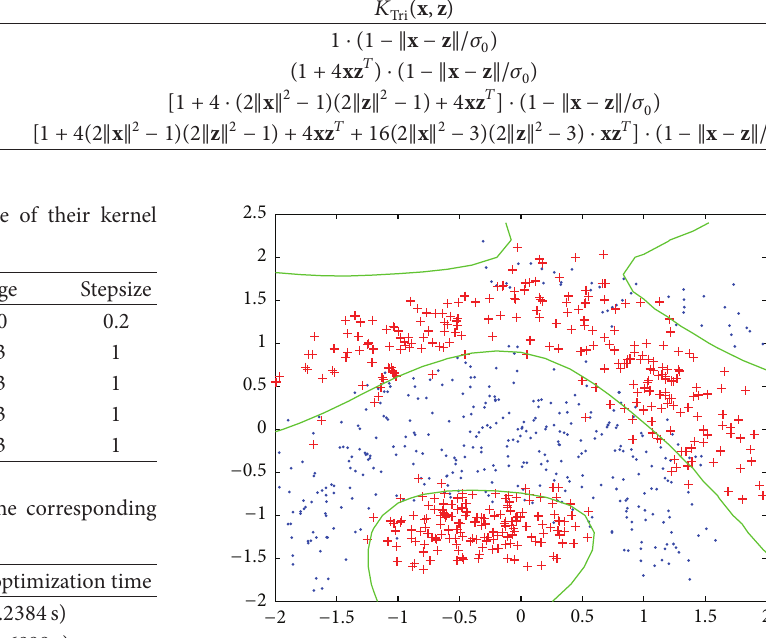
Figure 6: The boundaries of Gauss KELM algorithms in Banana dataset.